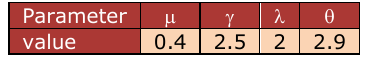
Table 3. Parameter Value of Strange Passengers